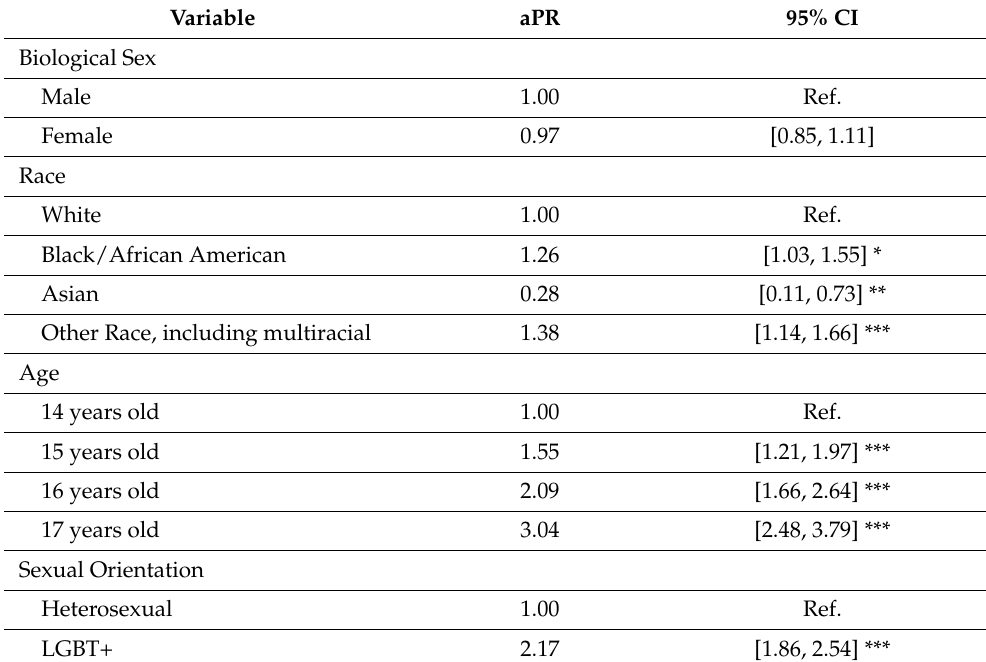
Table 2. Multivariate regression